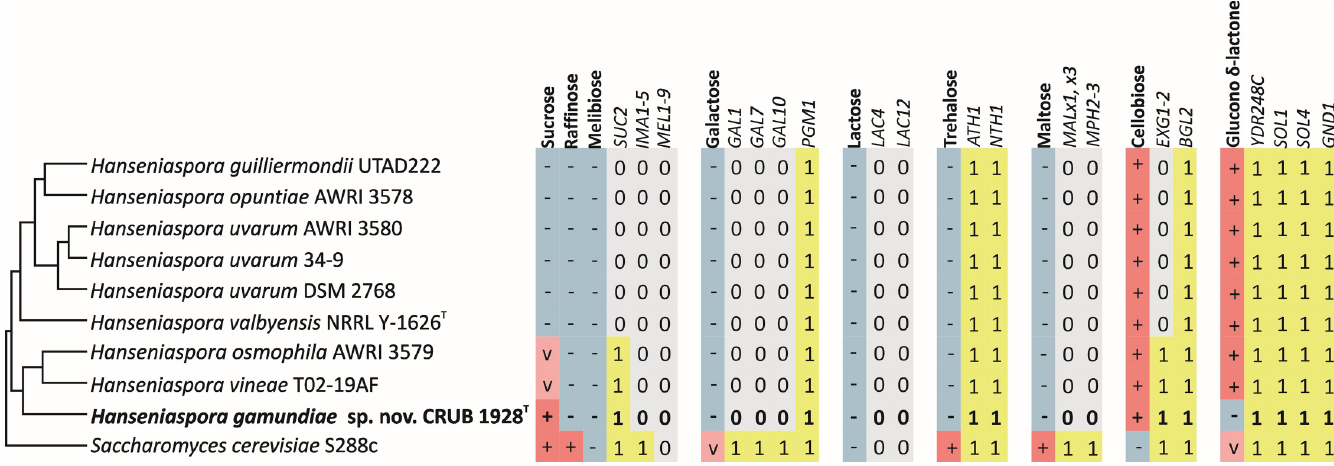
Fig 4. Metabolic traits and genes for the assimilation of the carbon sources sucrose, raffinose, melibiose, galactose, lactose, trehalose, maltose, cellobiose, and glucono δ -lactone by Hanseniaspora species and Saccharomyce cerevisiae (S288c). Numbered boxes indicate presence (1) or absence (0) of putative homologous genes determined by Reciprocal Best Hit (RBH) prediction algorithm. Physiological characteristics are from Kurtzman et al . [84], except for H . gamundiae .